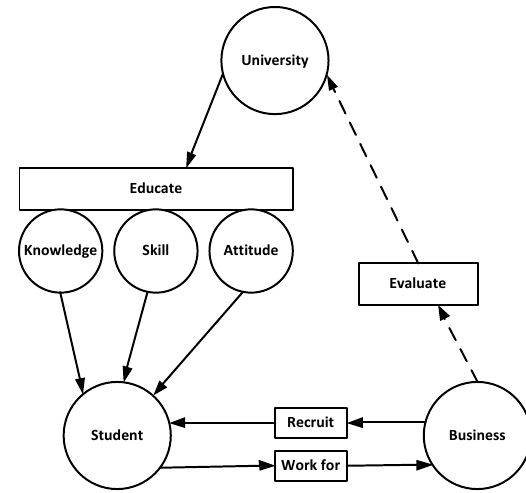
Figure 4. The triad of higher education “University – Student – Business”. The triad represents the relation between university, student, and business, where university educates students on knowledge, skill, and attitude to meet the recruitment need of business, meanwhile business recruits students demand (Source: “Evaluating the competence of